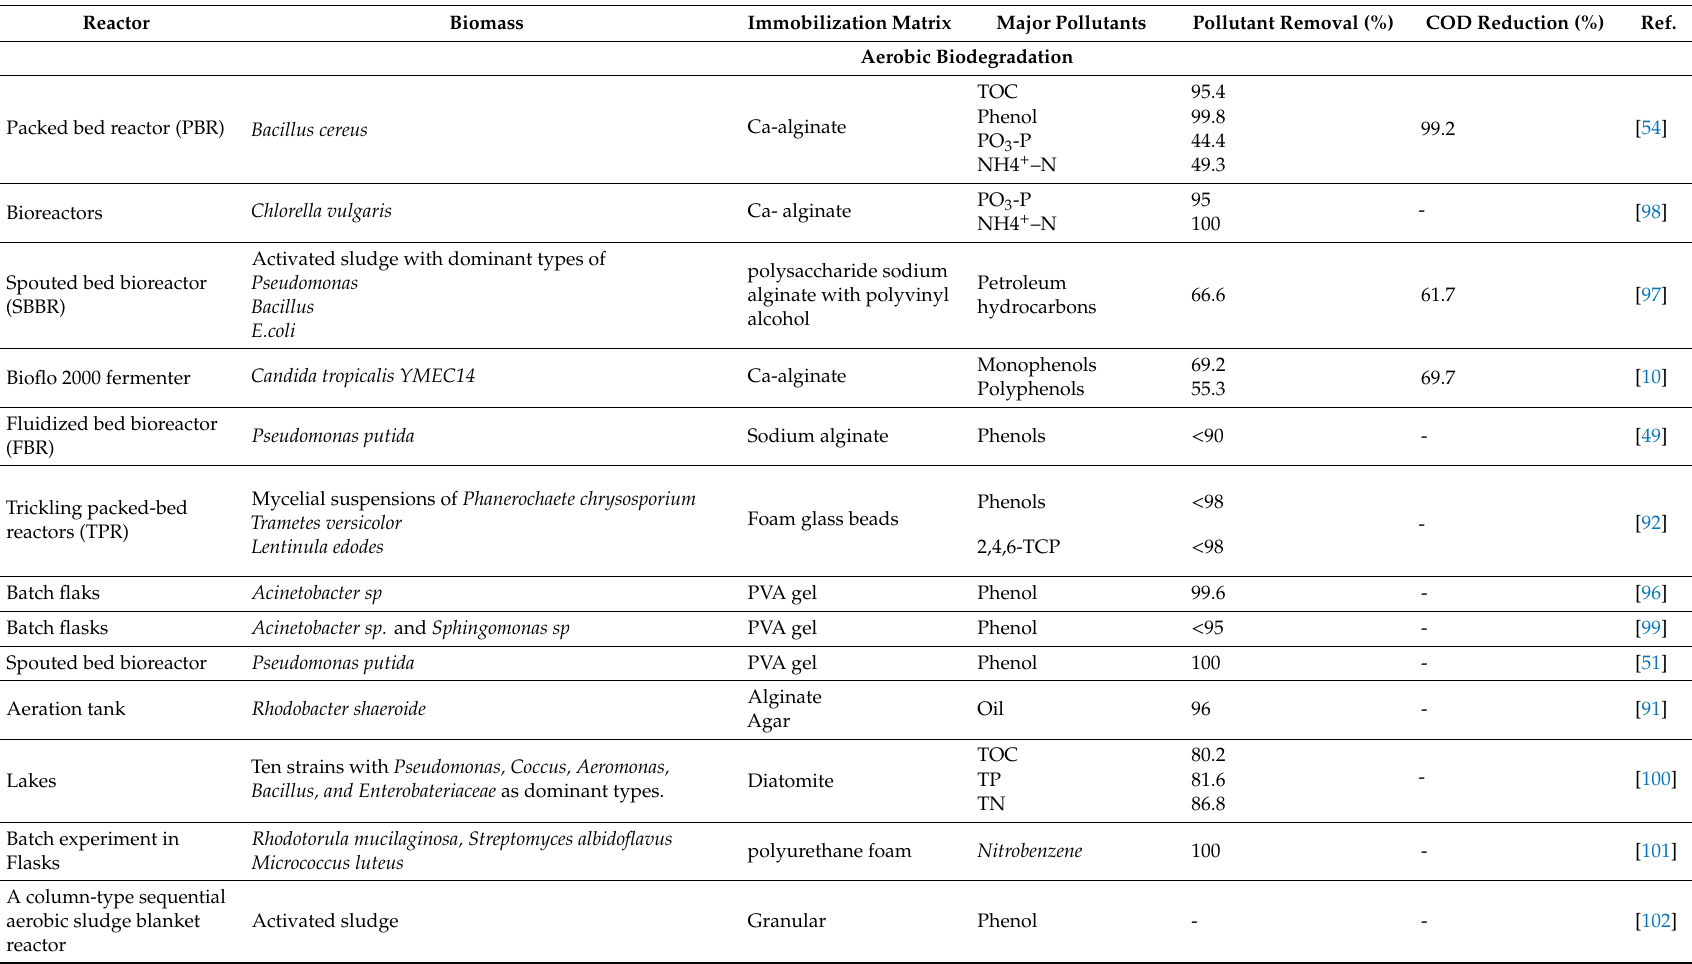
Table 5. Immobilization of microorganism for biological wastewater treatment under aerobic and anaerobic